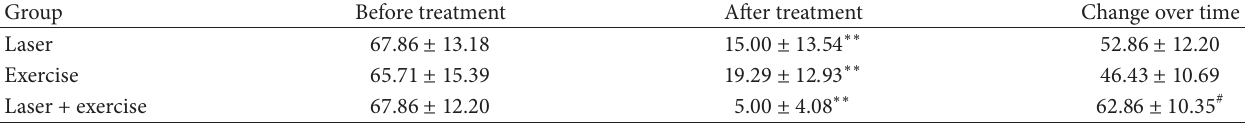
Table 1: Changes in VAS score before and after treatment in all therapy groups.